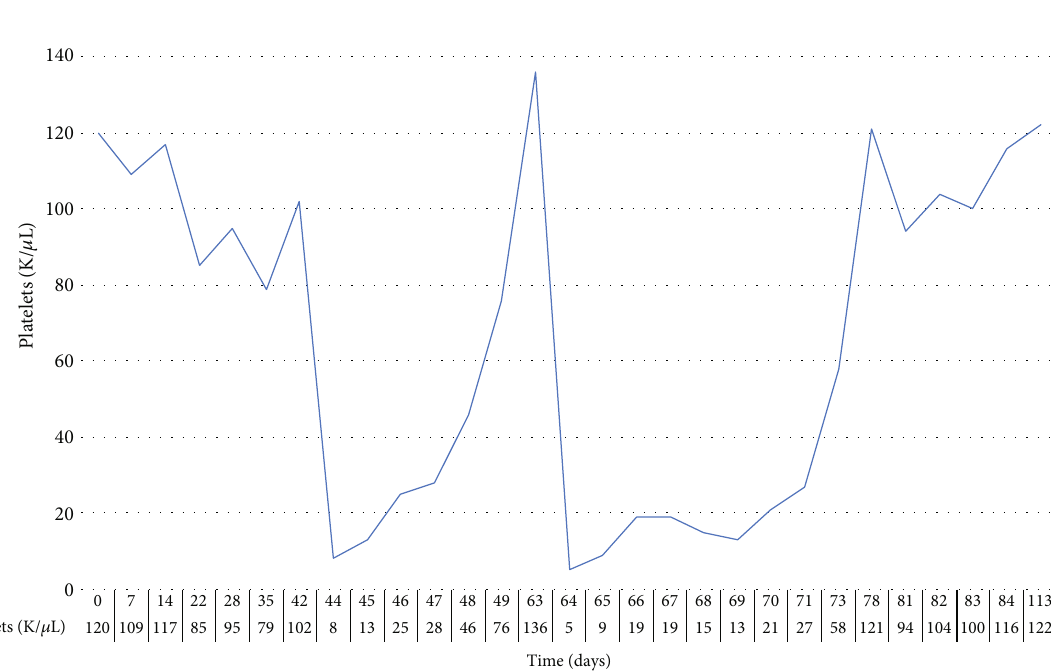
Figure 1: Platelet count over time for the two episodes of thrombocytopenia from oxaliplatin and irinotecan infusion with subsequent recovery.